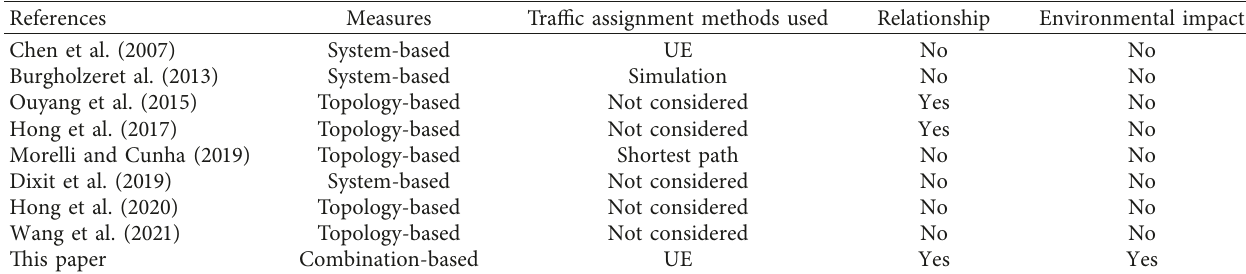
Table 2: Studies of multimodal transportation system